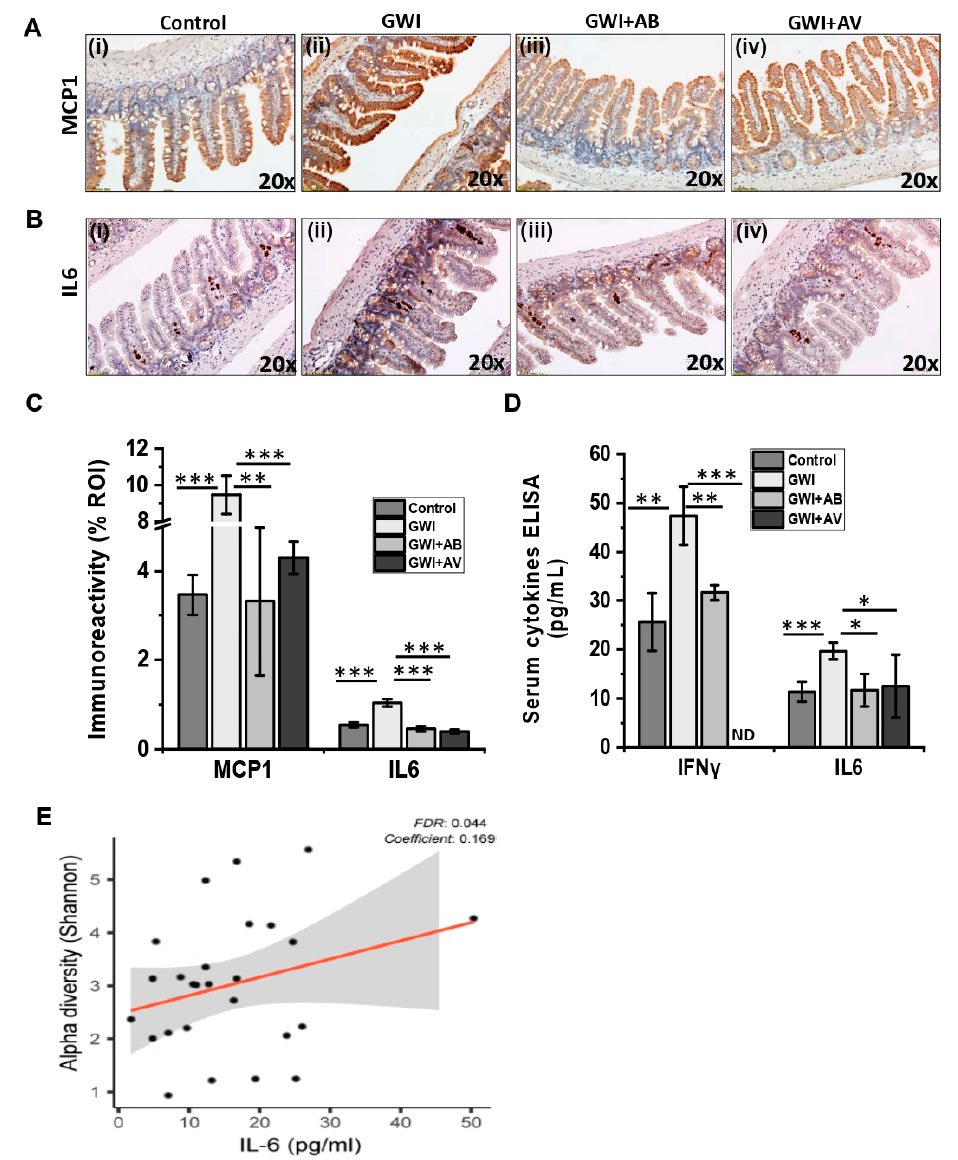
Figure 5. Anti-viral or antibiotic intervention ameliorates intestinal inflammation in GWI. Representative immunohistochemistry images of small intestine showed immunoreactivity of MCP1 ( A ) and IL6 ( B ) in control, GWI (Gulf war chemical exposed mice), GWI + AB (Gulf War chemical and antibiotic exposed mice), and GWI + AV (Gulf War chemical and antiviral-treated mice). 3–10 images were taken from the different microscopic field of each group at 20 × magnification. ( C ) The morphometric analysis (calculated as % ROI) of images were plotted as a bar graph. ( D ) Serum IFN γ and IL6 levels in pg / mL were plotted as a bar graph. IFN γ levels in GWI + AV group were below the detection limit and represented as ND (not detectable). For both ( C ) and ( D ) data points were represented with means ± SEM. Statistical significance was calculated using unpaired t -test; * p < 0.05, ** p < 0.01, *** p < 0.001. ( E ) Correlation plot of virome Shannon diversity index by serum IL-6. Results of multivariate analyses for association with serum ELISA measurements are shown. Linear regression is shown in red, 95% confidence bands are indicated in gray. False discovery rate (FDR), FDR adjusted q-value; Coefficient, regression coefficient.